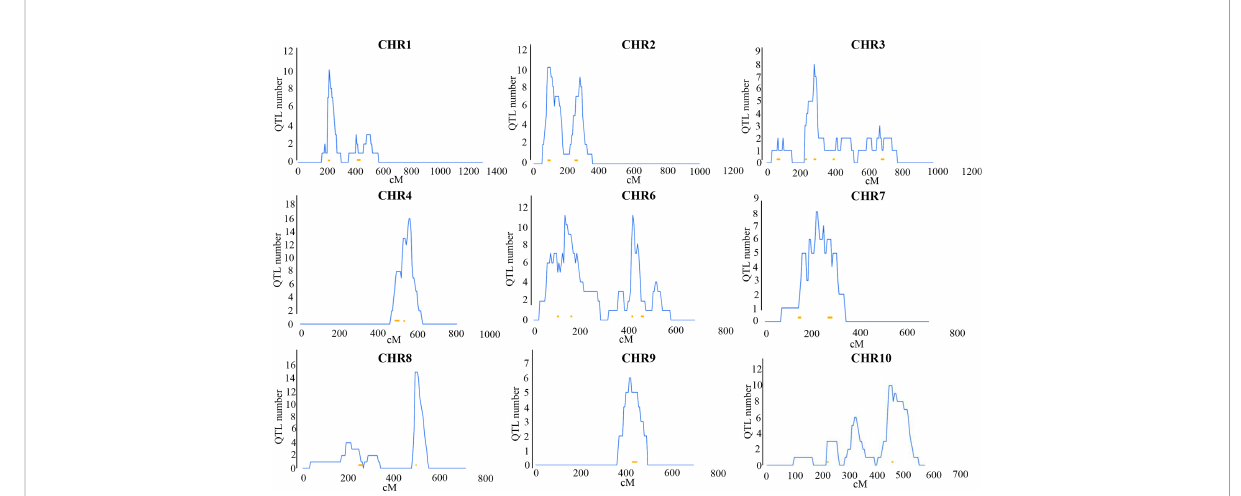
FIGURE 2 Distribution of 22 scQTLs on reference map IBM2 2008 neighbors. Vertical coordinates represent QTL numbers and horizontal coordinates re fl ect linkage distances of the reference map. The curves on these maps represent the density of QTLs on each chromosome. The lengths and placements of bold lines are subjective and should only for rough reference